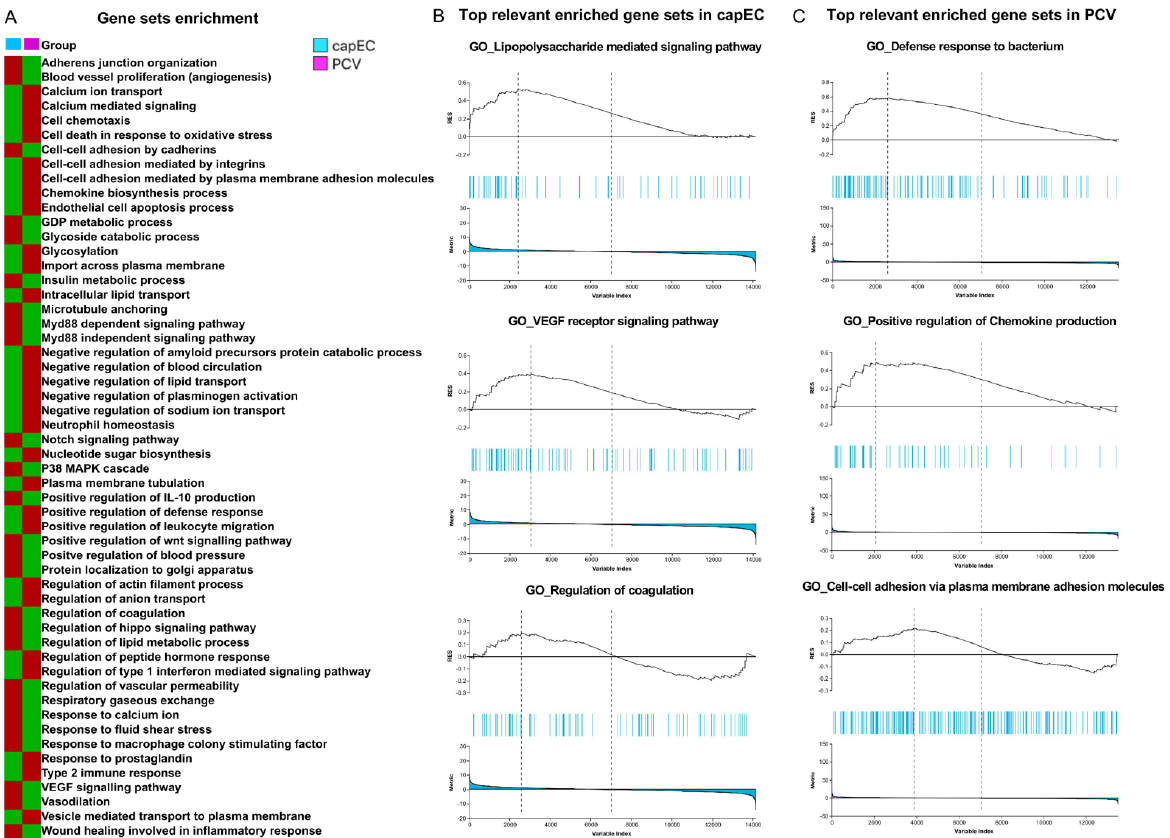
Figure 4. Gene sets enrichment analysis. ( A ) Heat map showing differentially enriched GO pathways based on normalized enrichment score in lung capEC and PCV after induction of sepsis, red indicates higher gene sets enrichment and green indicates lower gene sets enrichment. ( B ) Top three relevant enriched gene sets (human orthologs) in lung capEC. ( C ) Top three relevant enriched gene sets (human orthologs) in lung PCV. For GSEA analysis, mouse genes are converted to human orthologs as described in the materials and methods section. GSEA analysis was performed using gene sets derived from the GO Biological Process (BP) ontology of the Molecular Signatures Database (v7.2 MSigDB). Plots show running enrichment score (RES), the match positions for the genes (blue lines) in the selected data set and the ranking metric values for the input gene list.